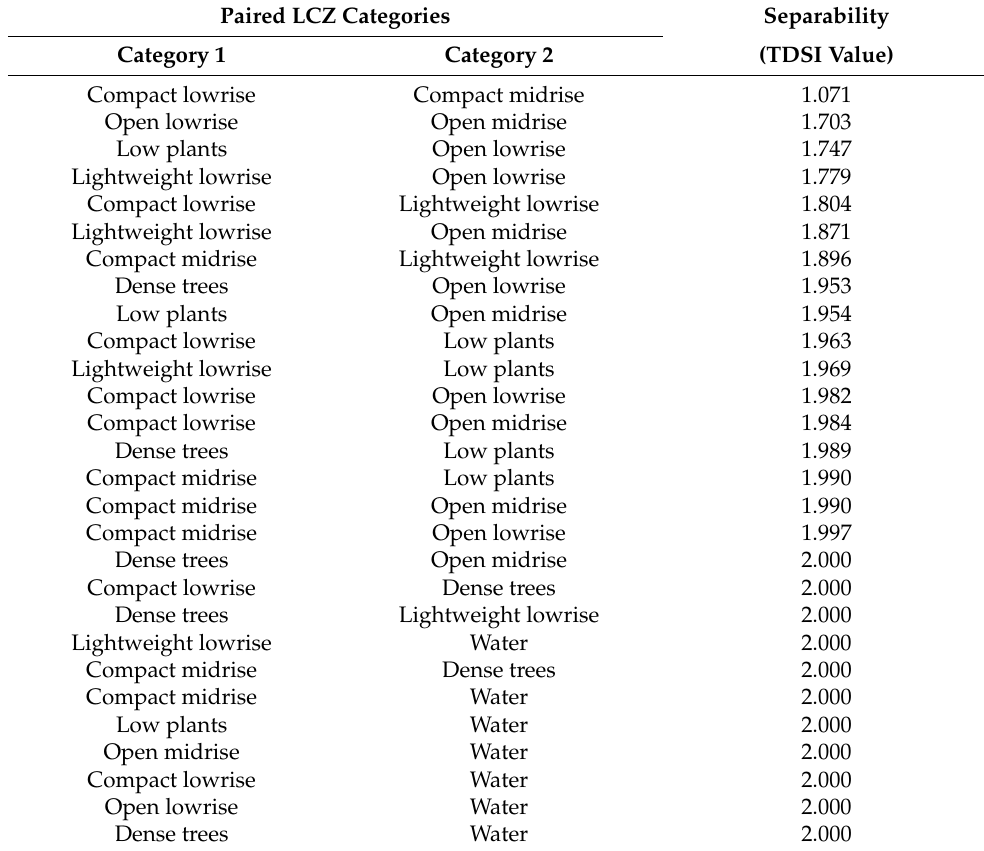
Table 2. Separability LCZs using Landsat 8 data and digitized training